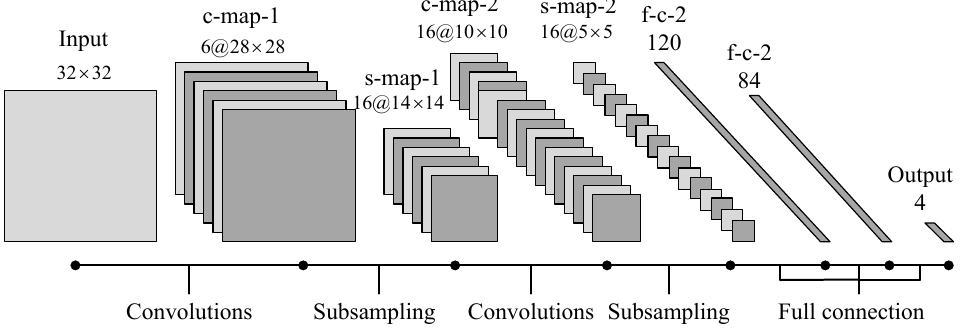
Figure 12. Architecture of the LeNet-5 model.